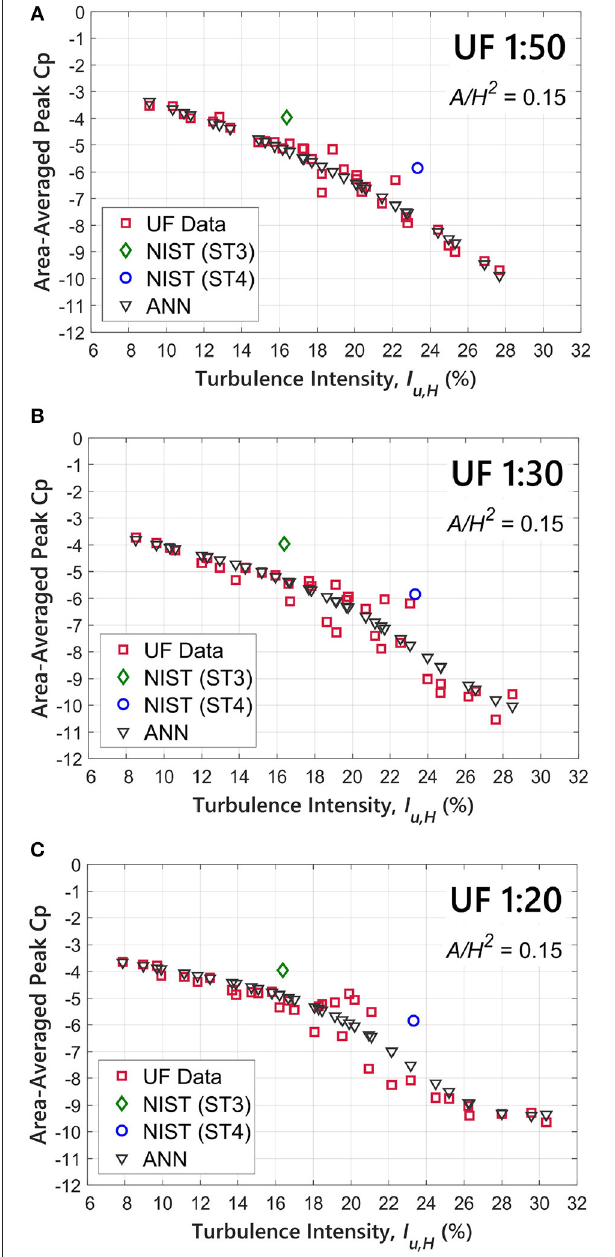
FIGURE 11 | Area-averaged peak pressures from six corner roof taps (Tap IDs 215, 216, 301, 314, 315, and 316) as a function of freestream turbulence: (A) 1:50, (B) 1:30, and (C)